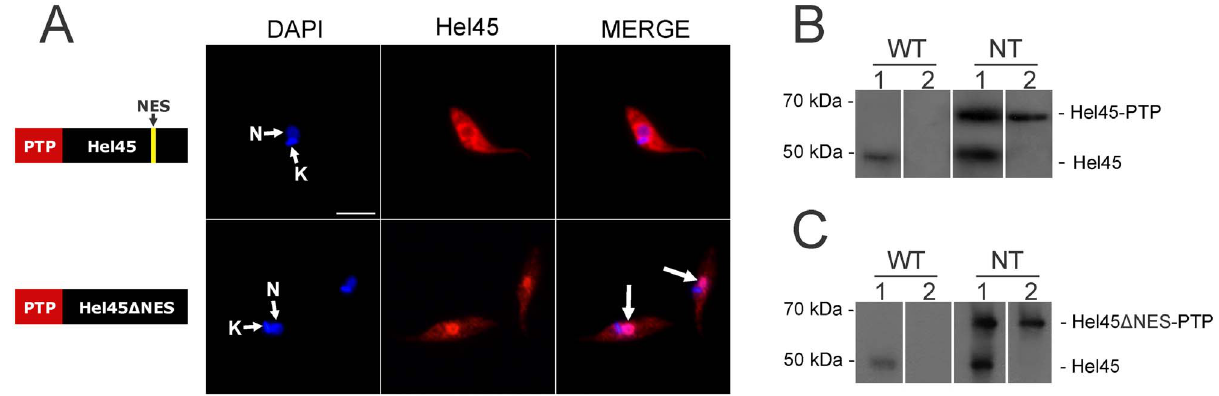
Figure 4. Cellular localization of tagged Hel45 in Trypanosomacruzi . (A) Detection of exogenous Hel45 and a Hel45 NES deletion mutant (Hel45 D NES) (both tagged with PTP at the NT) by indirect immunofluorescence microscopy with an anti-ProtA antibody. DAPI=DNA stained with DAPI. Hel45= localization of tagged Hel45 or Hel45 D NES. MERGE=merged images for DAPI staining and Hel45 localization. N=nucleus. K=kinetoplast. Arrows=parasites with nuclear accumulation of tagged Hel45. Bar=5 m m. (B and C) Western blot of total extract from wild-type epimastigotes (WT) and epimastigotes expressing recombinant Hel45 (B) or Hel45 D NES (C) tagged with a PTP at the N-terminus (NT). Lane 1= detection with anti-Hel45 antibodies. Lane 2= detection with anti-ProtA antibodies.